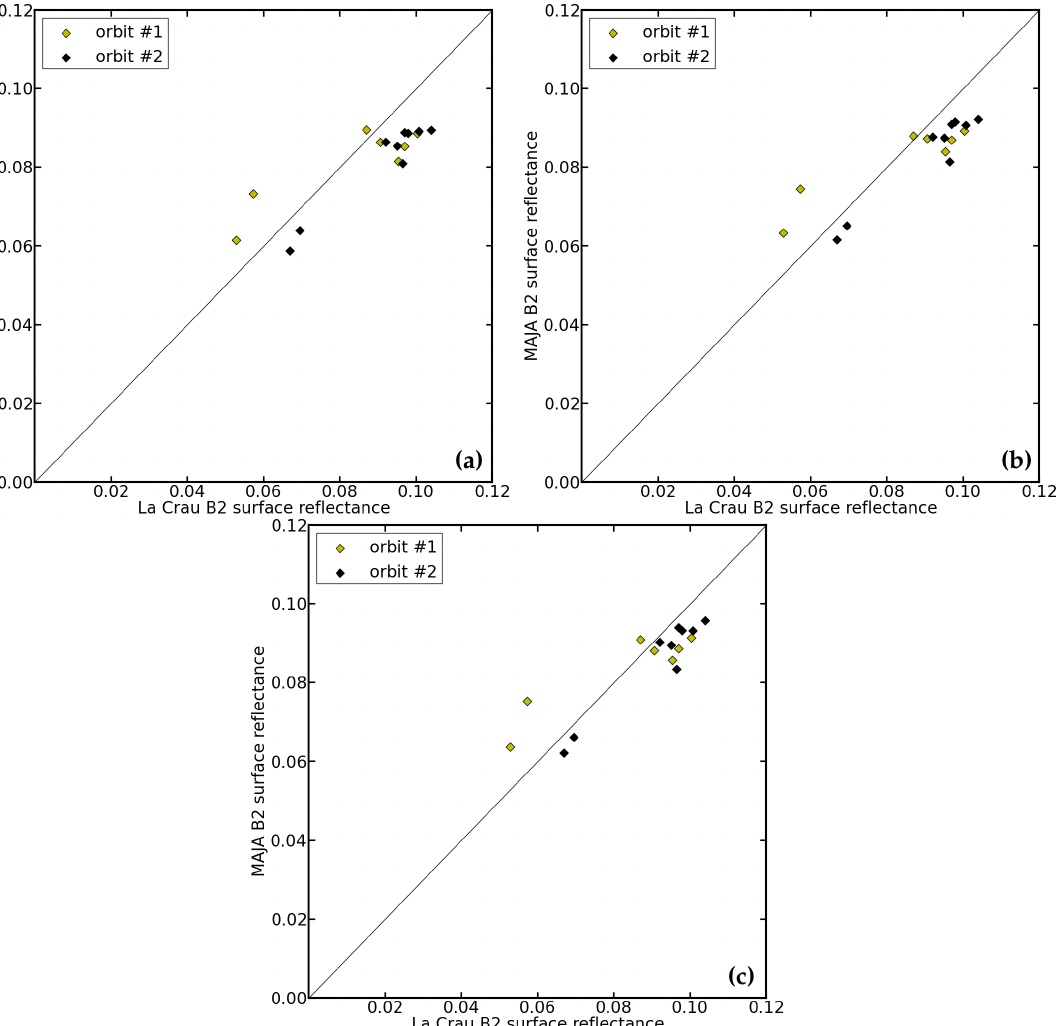
Figure 6. For the B2 band (496 nm), surface reflectances calculated by the MACCS-ATCOR Joint Algorithm (MAJA) as a function of La Crau observations: ( a ) with a constant aerosol type; ( b ) with four CAMS (Copernicus Atmosphere Monitoring Service) aerosol types; and ( c ) with five CAMS aerosol